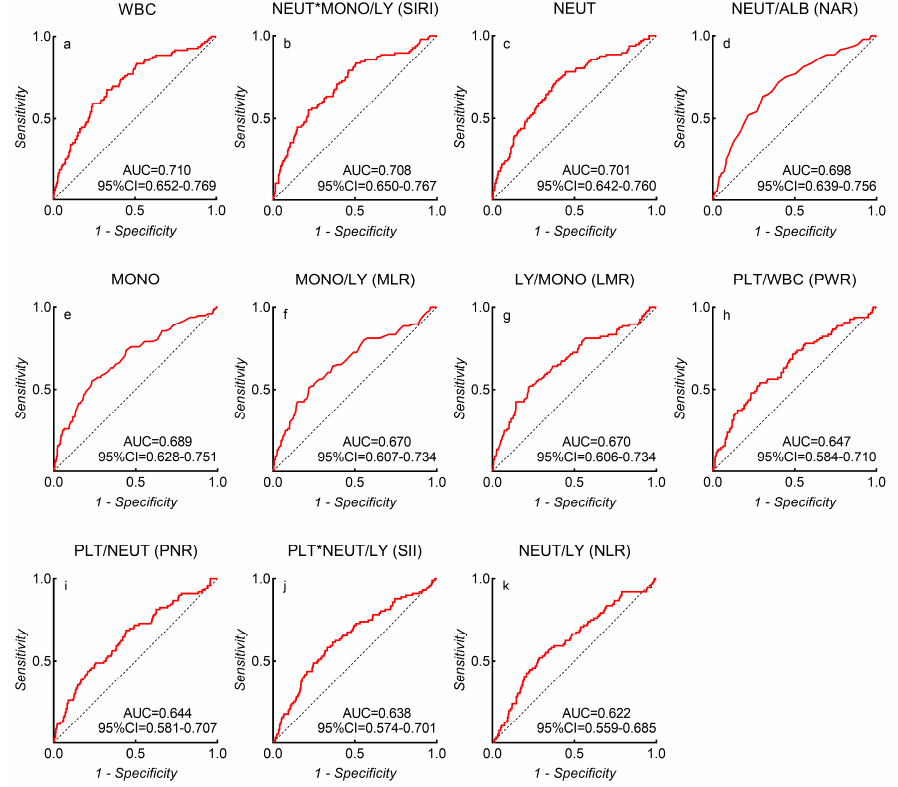
Figure 2. The AUC values of each inflammatory biomarker-related risk factor that predict 90-day unfavorable outcomes in aSAH patients. ( a ) WBC; ( b ) SIRI; ( c ) NEUT; ( d ) NAR; ( e ) MONO; ( f ) MLR; ( g ) LMR; ( h ) PWR; ( i ) PNR; ( j ) SII; ( k ) NLR.